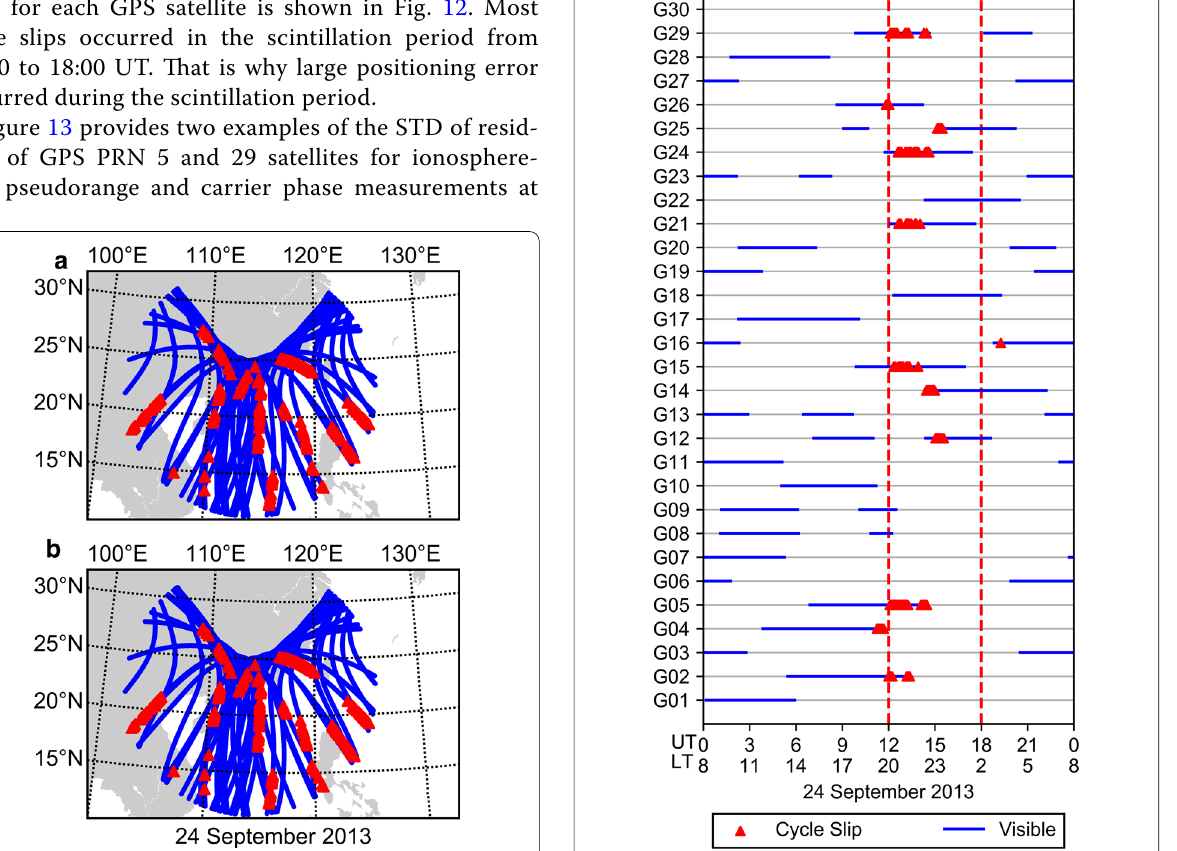
Fig. 12 Visibility and cycle slip of each GPS satellite derived from the HKPC station on 24 September 2013. The horizontal blue lines denote the visibility of the GPS satellites. The red triangles on the blue line are cycle slips. The scintillation period is from 12:00 to 18:00 UT represented with two vertical red dashed